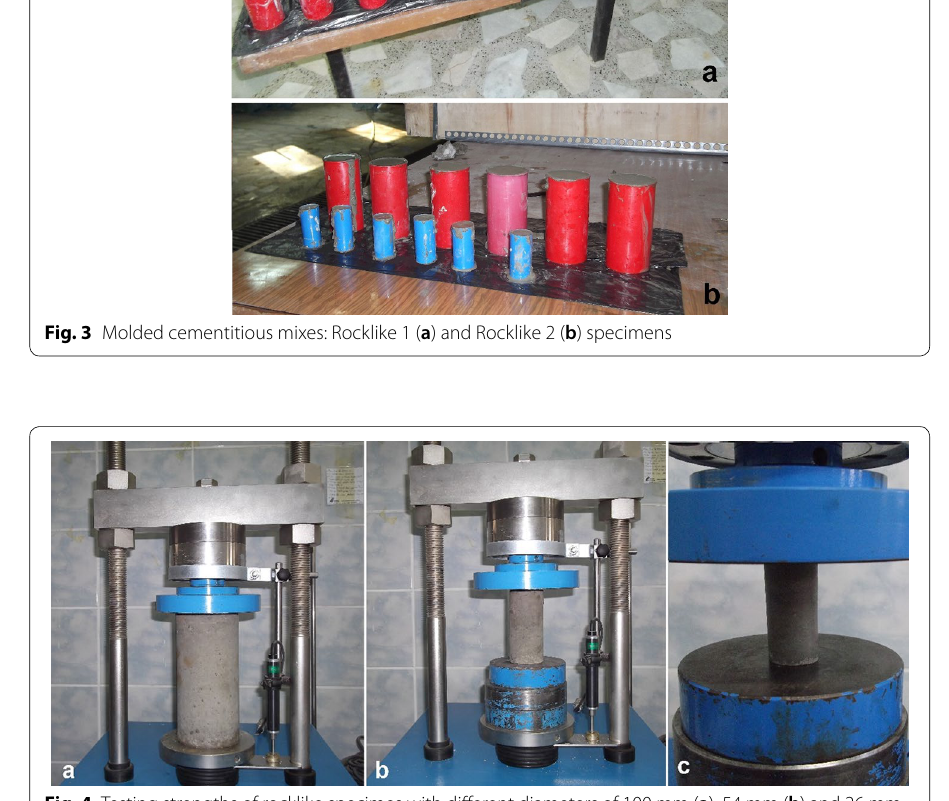
Fig. 4 Testing strengths of rocklike specimes with different diameters of 100 mm ( a ), 54 mm ( b ) and 26 mm ( c